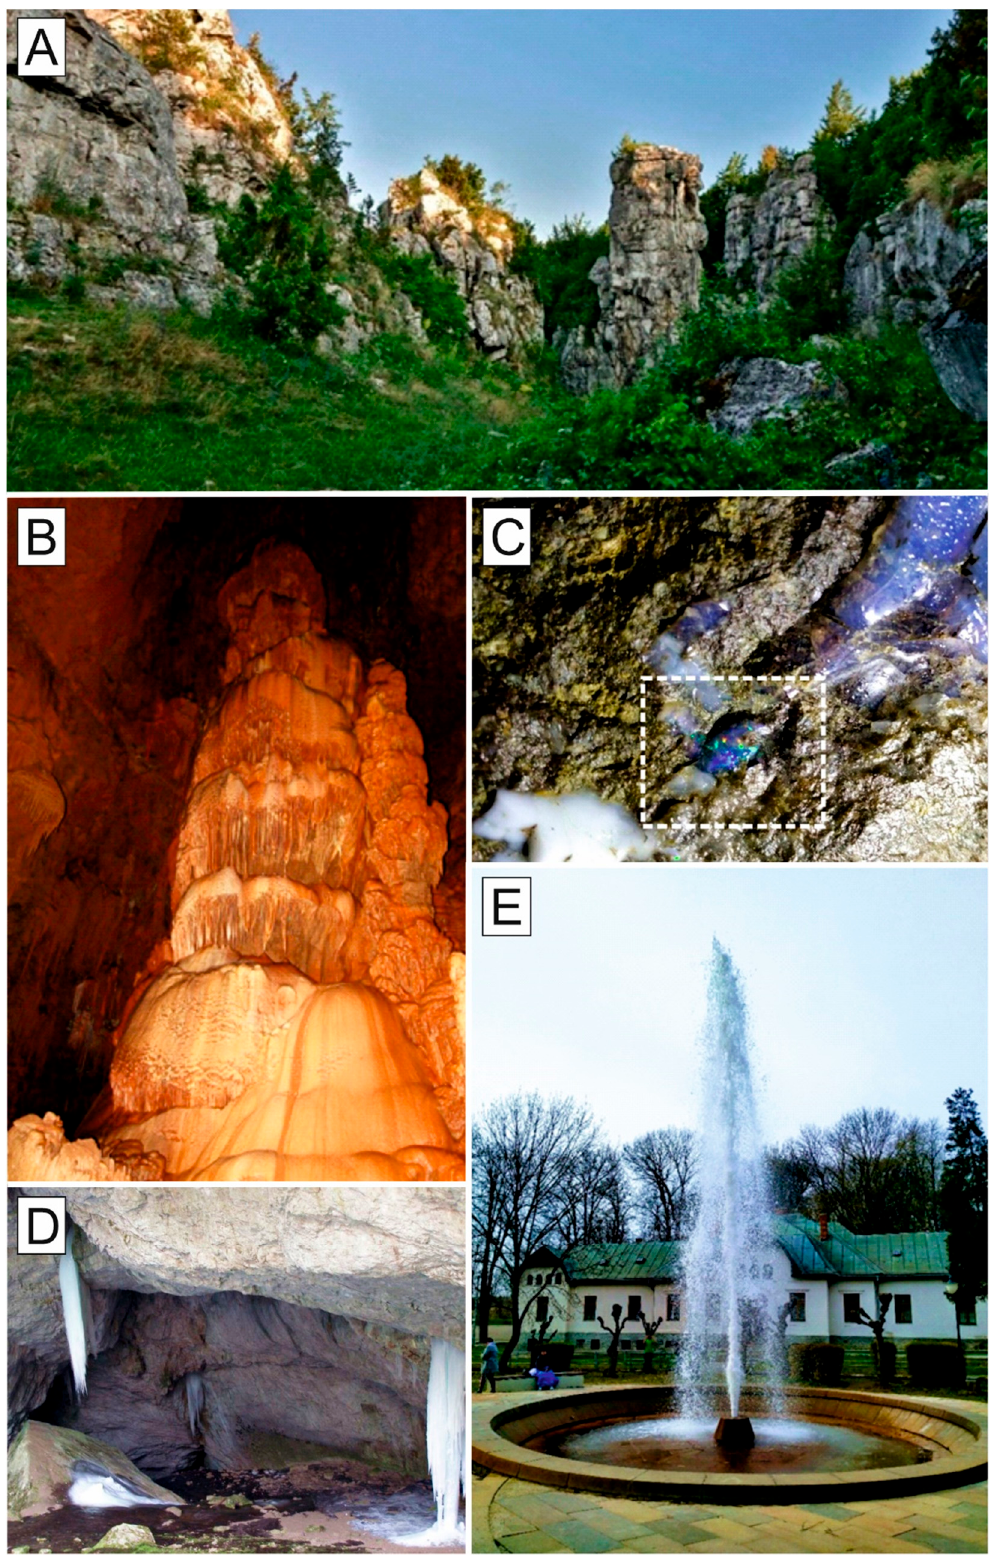
Figure 2. Examples of geological phenomena in Slovakia. ( A ) Karstified travertine at Dreveník; ( B ) Speleothreme concretions of Krásnohorská jasky ň a Cave (Speleologists of Rož ň ava Dripstone in the forefront); ( C ) precious opal from the Dubnik Opal Mines highlighted in the white dashed box; ( D ) the karstified Mesozoic limestone in of the Silická ľ adnica Cave; ( E ) the monumentalized Her ľ any Geyser which is active since 1872. Source: authors.